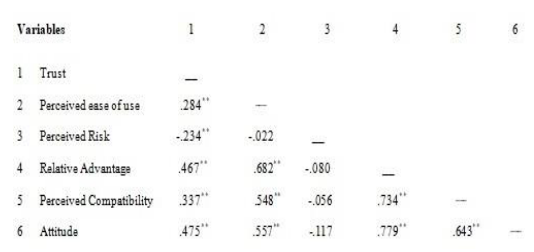
Table 4: Correlations between